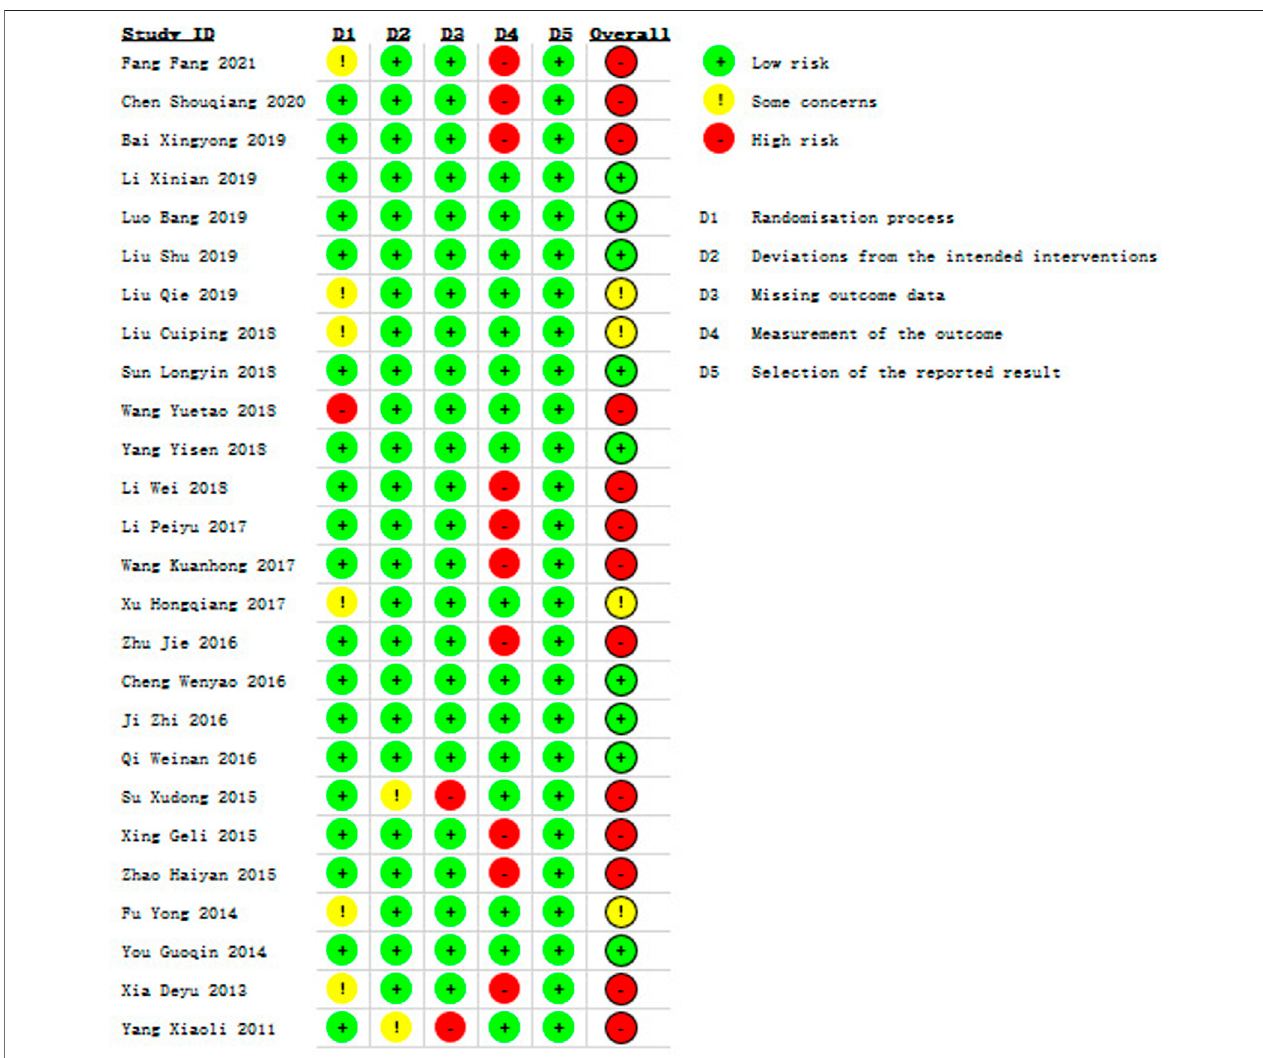
FIGURE 2 | Risk of bias